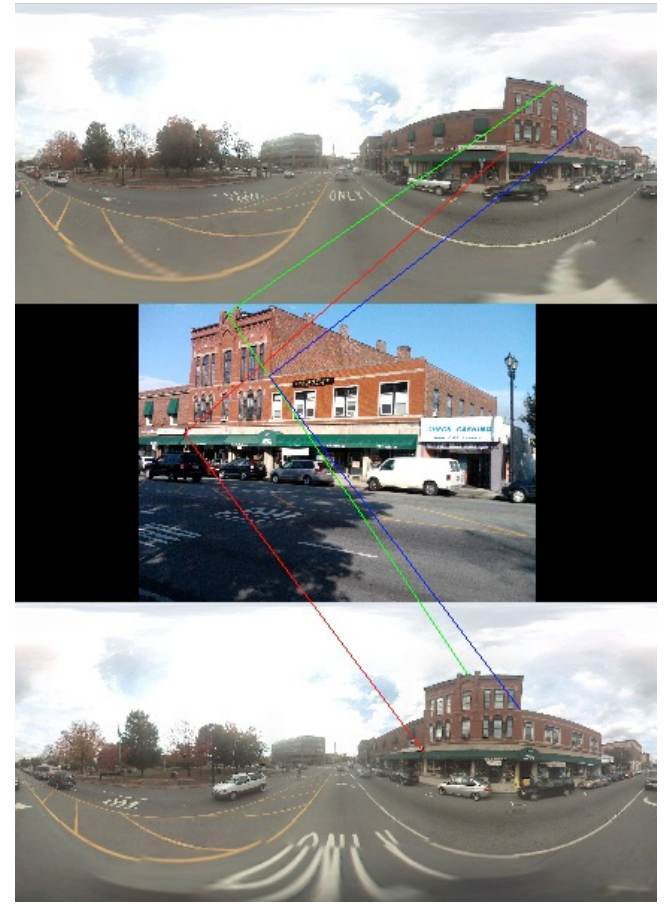
Figure 12. Location with respect to Google Street View